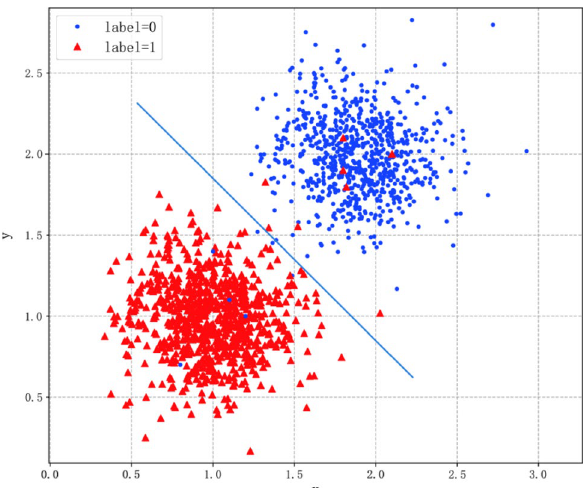
Figure 1. The points located in the low-density area near the dividing line are most prone to misclassification in the classification process. Most of them are low-quality images with background noise, while the wrong points located in the high-density area are mislabeled